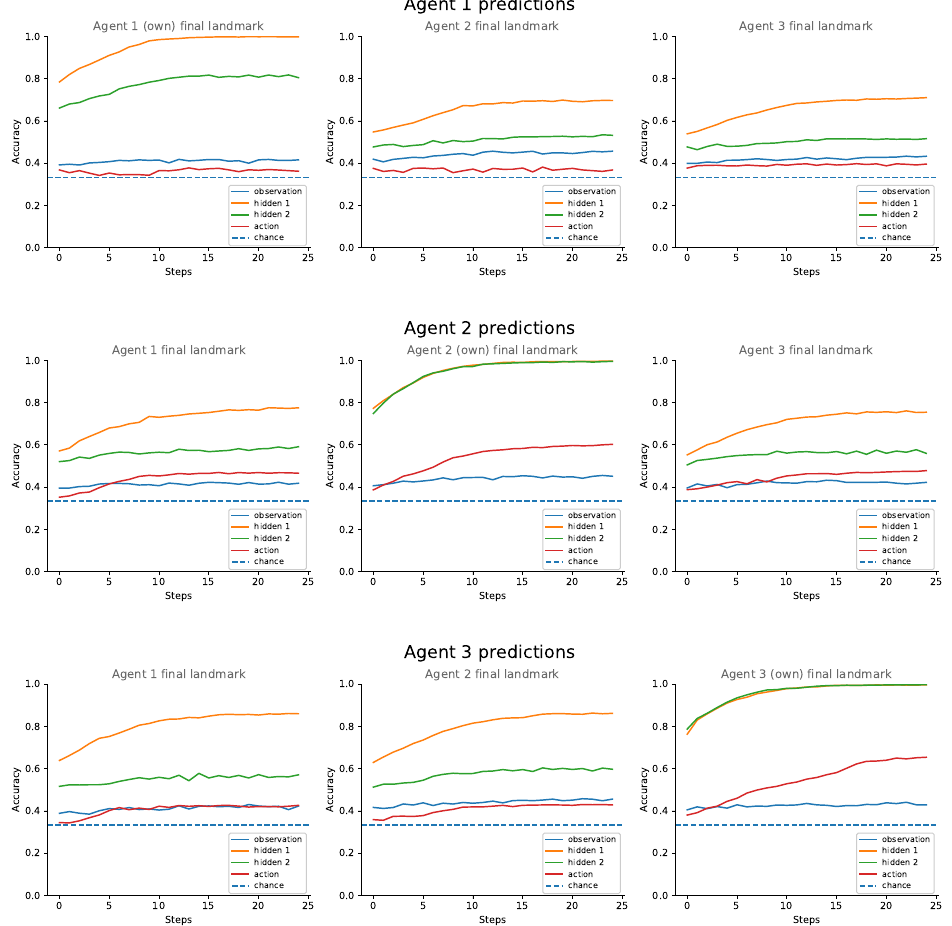
Figure 4. Cross-validated accuracy of a linear read-out probe for the MADDPG + shuffle scheme. All 9 combinations of 3 agents predicting the final landmarks of the other 3 agents are shown, including the agent predicting its own final target. The y-axis is the cross-validated accuracy of a linear read-out probe, and the x-axis is the timestep of an